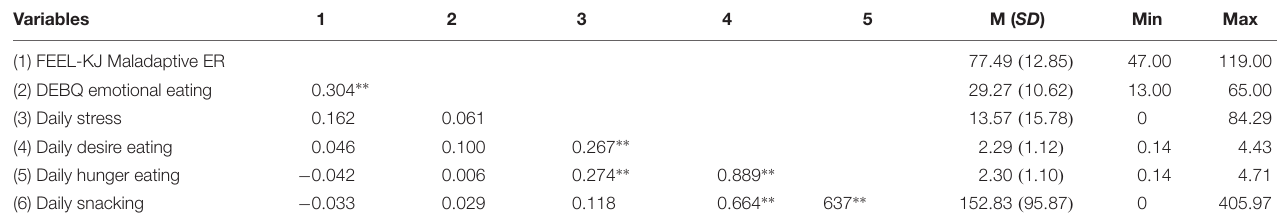
TABLE 2 | Variable correlations and